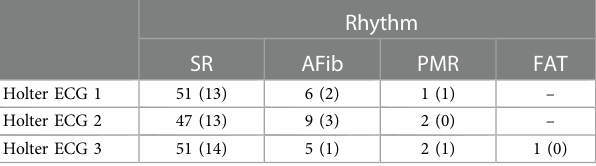
TABLE 2 Number of patients with each heart rhythm in the three consecutive Holter electrocardiograms.